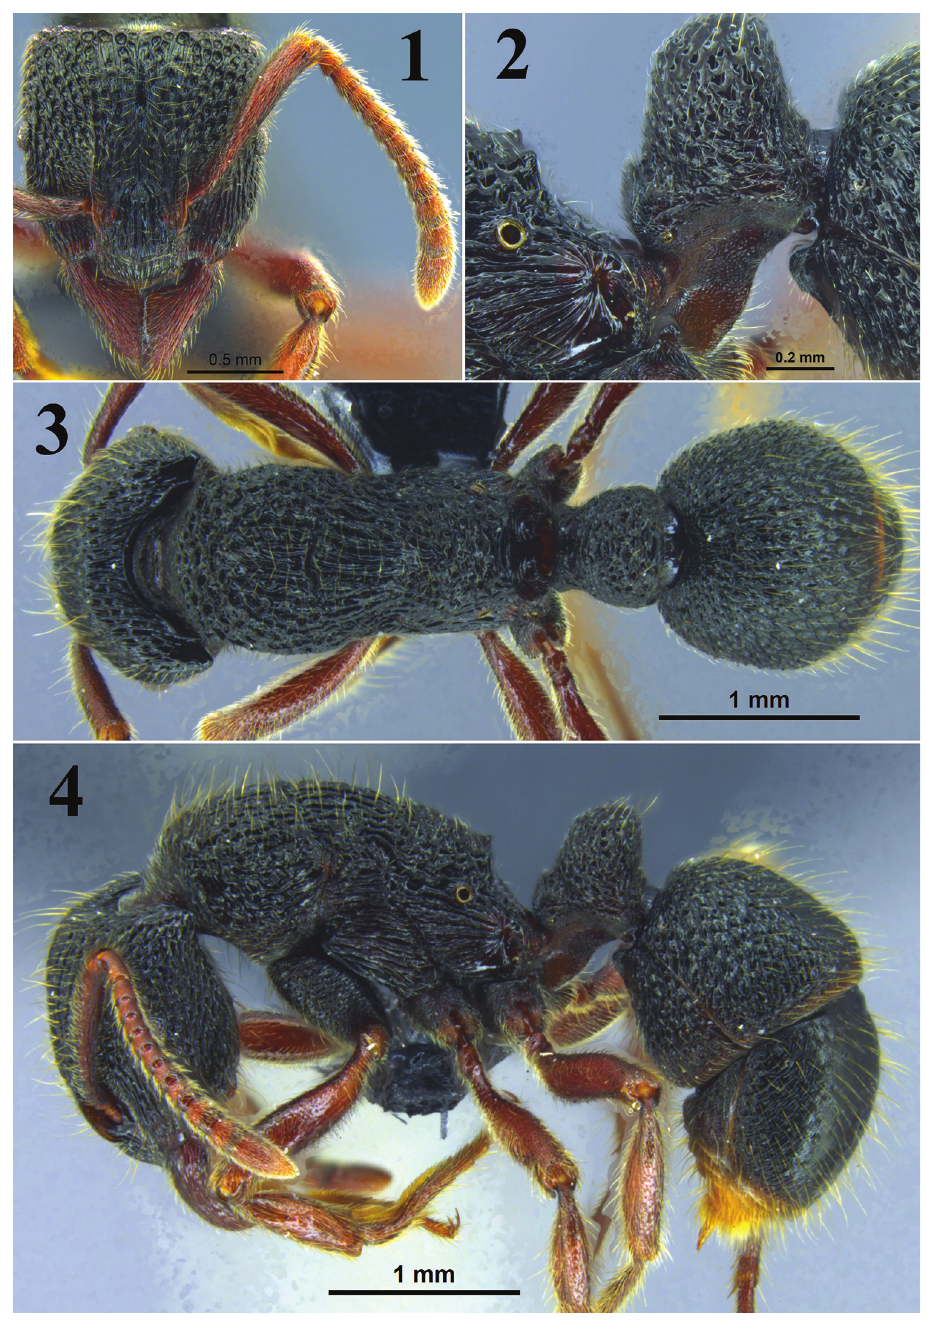
Figures 1–4. Gnamptogenys dentihumera holotype worker (No. G150067). 1 head in full-face view 2 petiole in lateral view 3 body in dorsal view 4 body in lateral